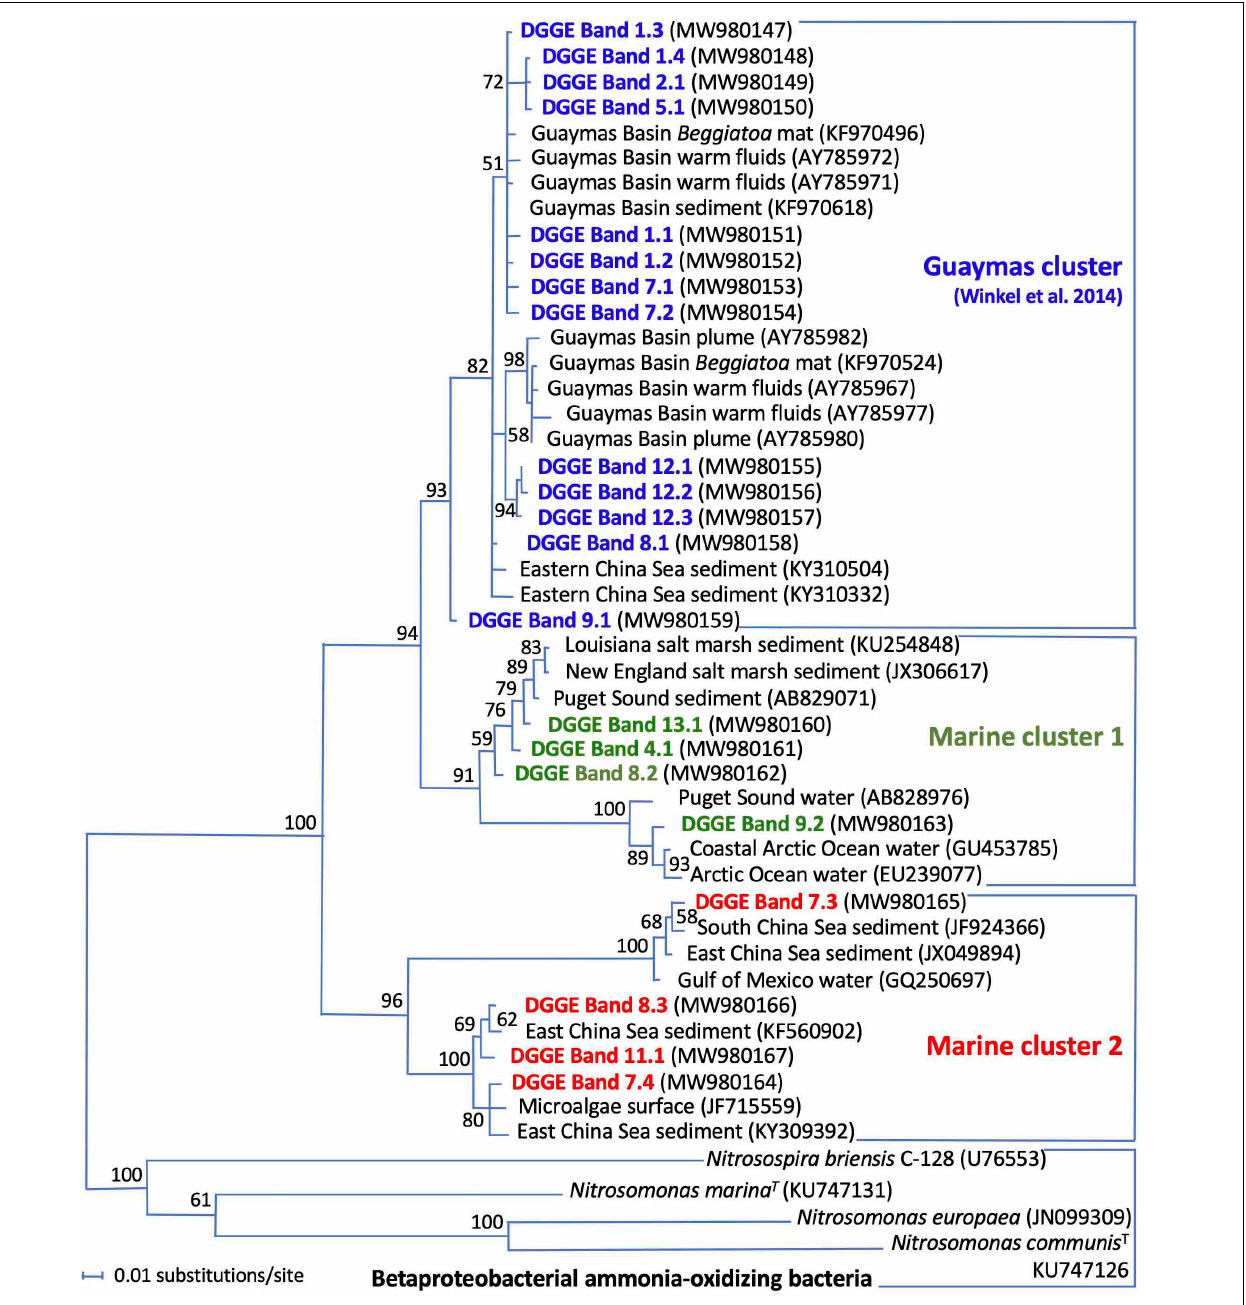
FIGURE 7 | Distance phylogeny of bacterial amoA gene DGGE fragments, based on complete amplicon length minus primer sequences, color-coded to match the DGGE bands in Figure 6 . Bootstrap support for nodes (in%) was derived from 1000